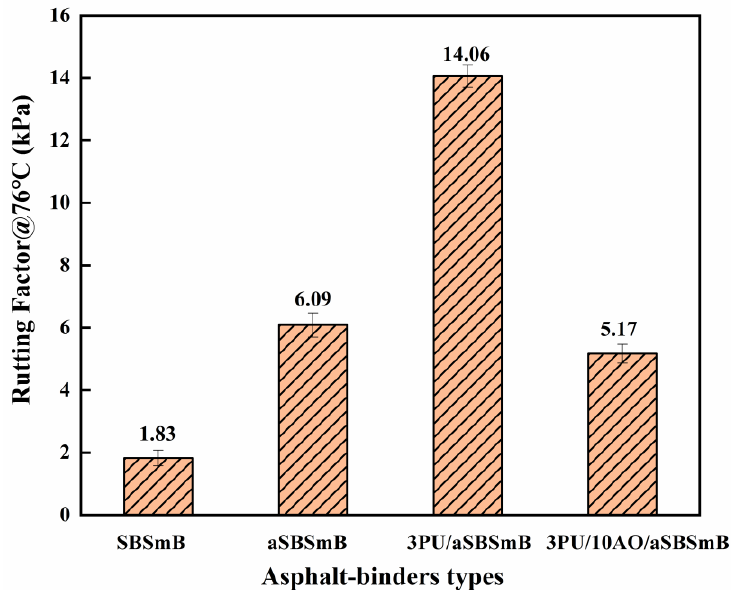
Figure 7. Effect of reaction rejuvenation on the rutting deformation resistance of aSBSmB.